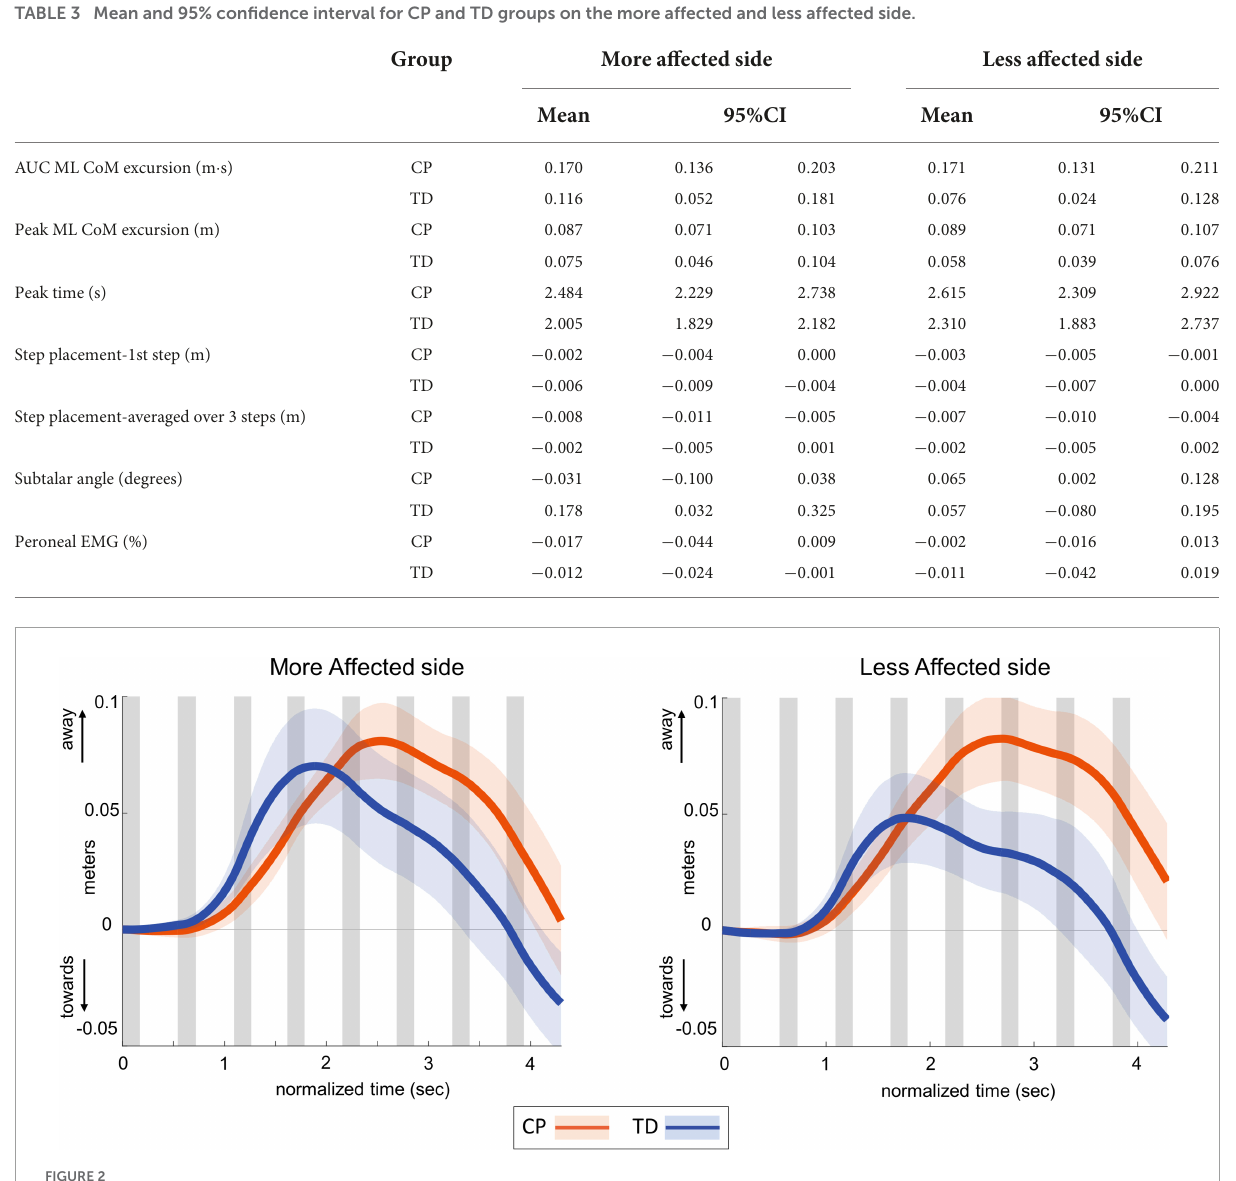
TABLE 3 Mean and 95% confidence interval for CP and TD groups on the more affected and less affected side.